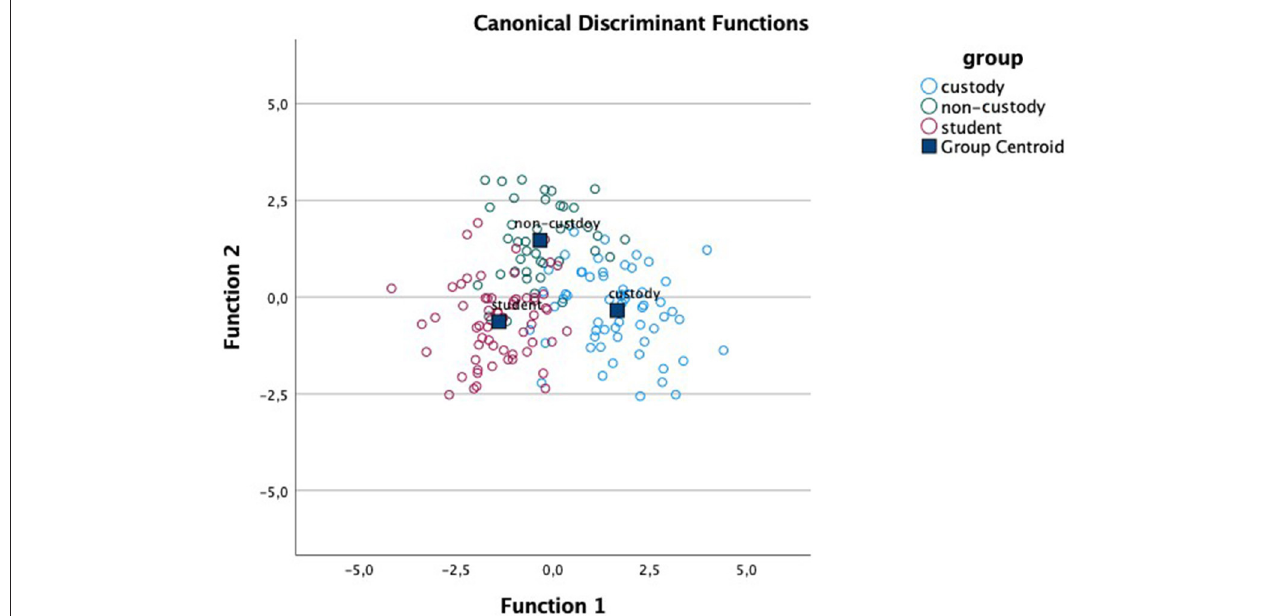
FIGURE 1 | Canonical discriminant functions for the dimension of valence.